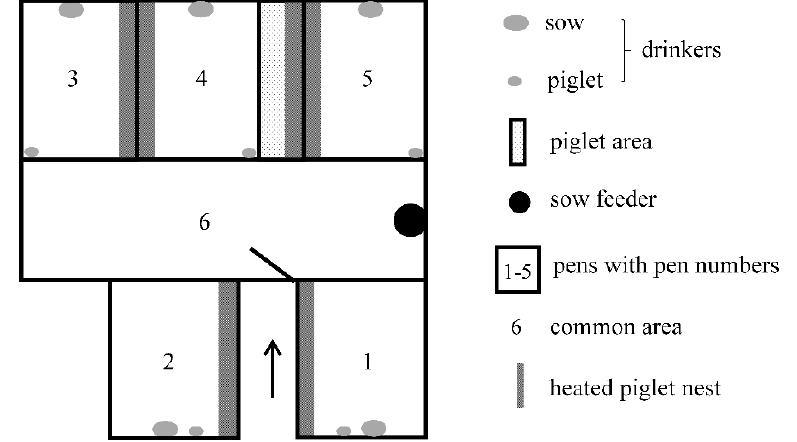
Figure 1. Group housing system layout with five farrowing pens and a central common area (published in Schrey et al. [31]).